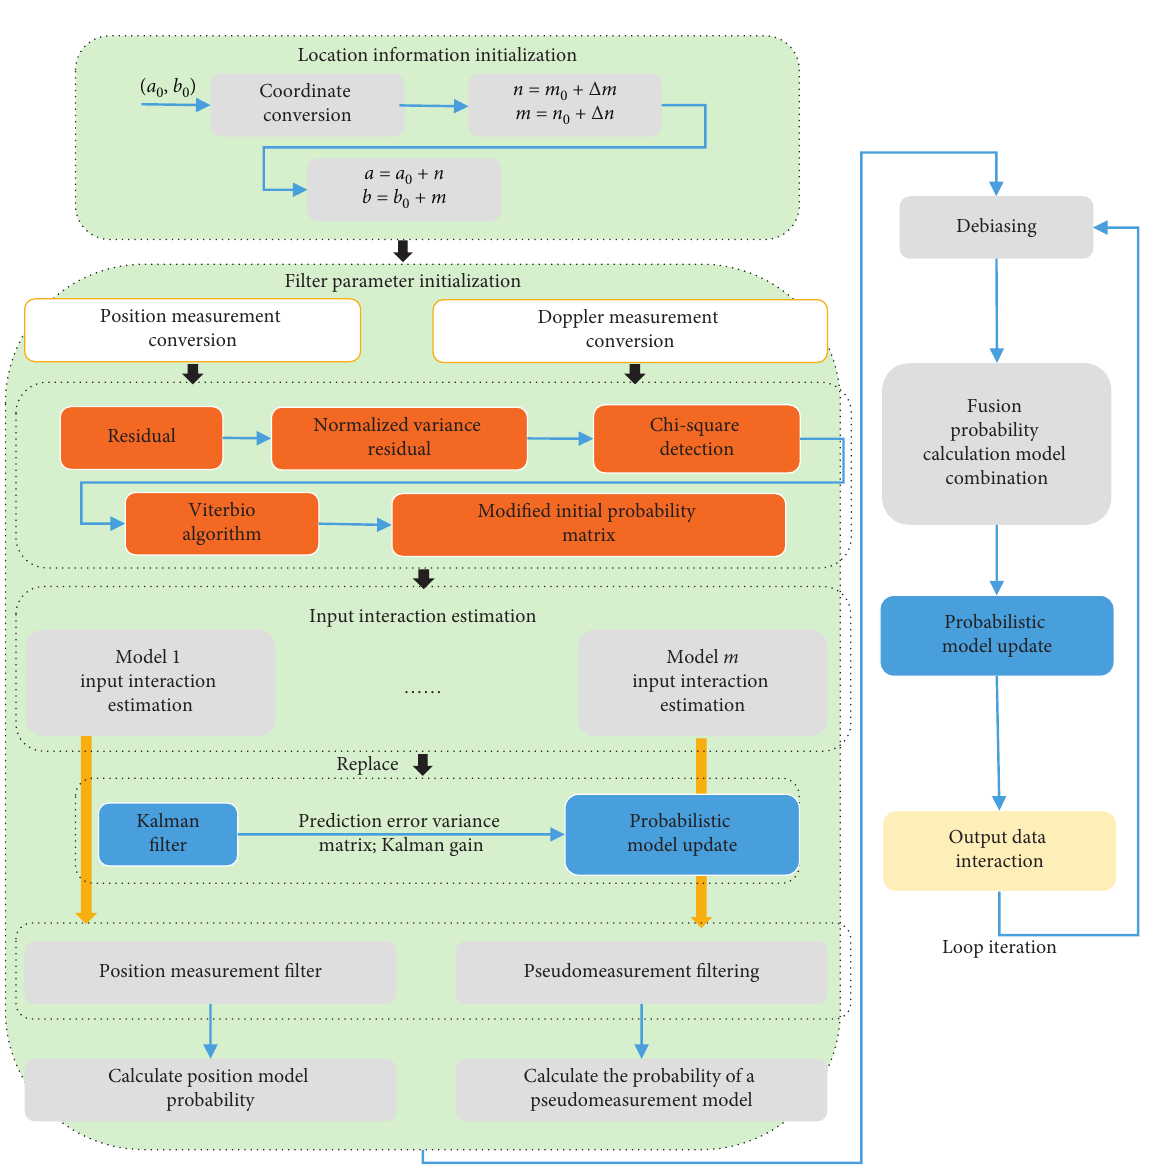
Figure 2: Block diagram of IMM-IKF algorithm